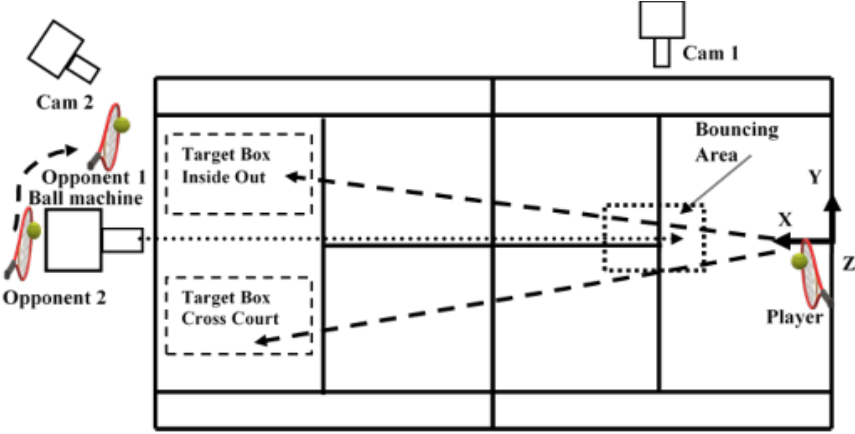
Figure 1. Testing environment. (1) One Lobster ball machine with the projection line toward the bouncing area, (2) one Qualisys Oqus 210c camera (Cam 1), (3) one Panasonic digital video camera (Cam 2), (4) coordinate system, (5) stroke direction, (6) bouncing area, (7) target boxes for the CC and IO direction forehands, (8) participant with Xsens IMUs, (9) opponents 1 and 2.